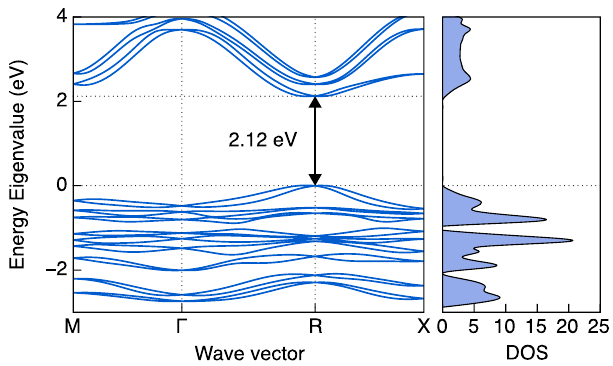
Fig. 5 Band structure and DOS of R3m N(CH 3 ) 4 SnI 3 . The high-symmetry wave vectors are M(1/2, 1/2, 0), Γ (0, 0, 0), R(1/2, 1/2, 1/2), and X(0, 1/2, 0). The Fermi level is shifted to 0 eV.